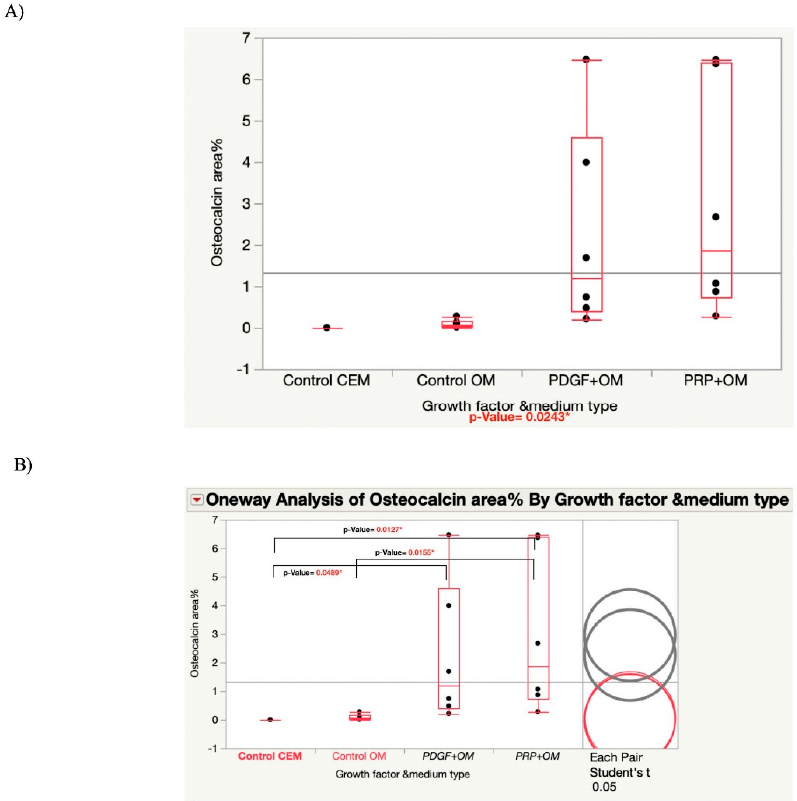
Figure 5. ( A ) Graph showing one-way ANOVA analysis of Osteocalcin fluorescence area% among the groups. ( B ) Graph showing one-way analysis of Osteocalcin fluorescence area% among the groups using pairwise student t -test. Significant differences are shown between the two groups us- ing growth factors compared with the two control groups. factors compared with the two control